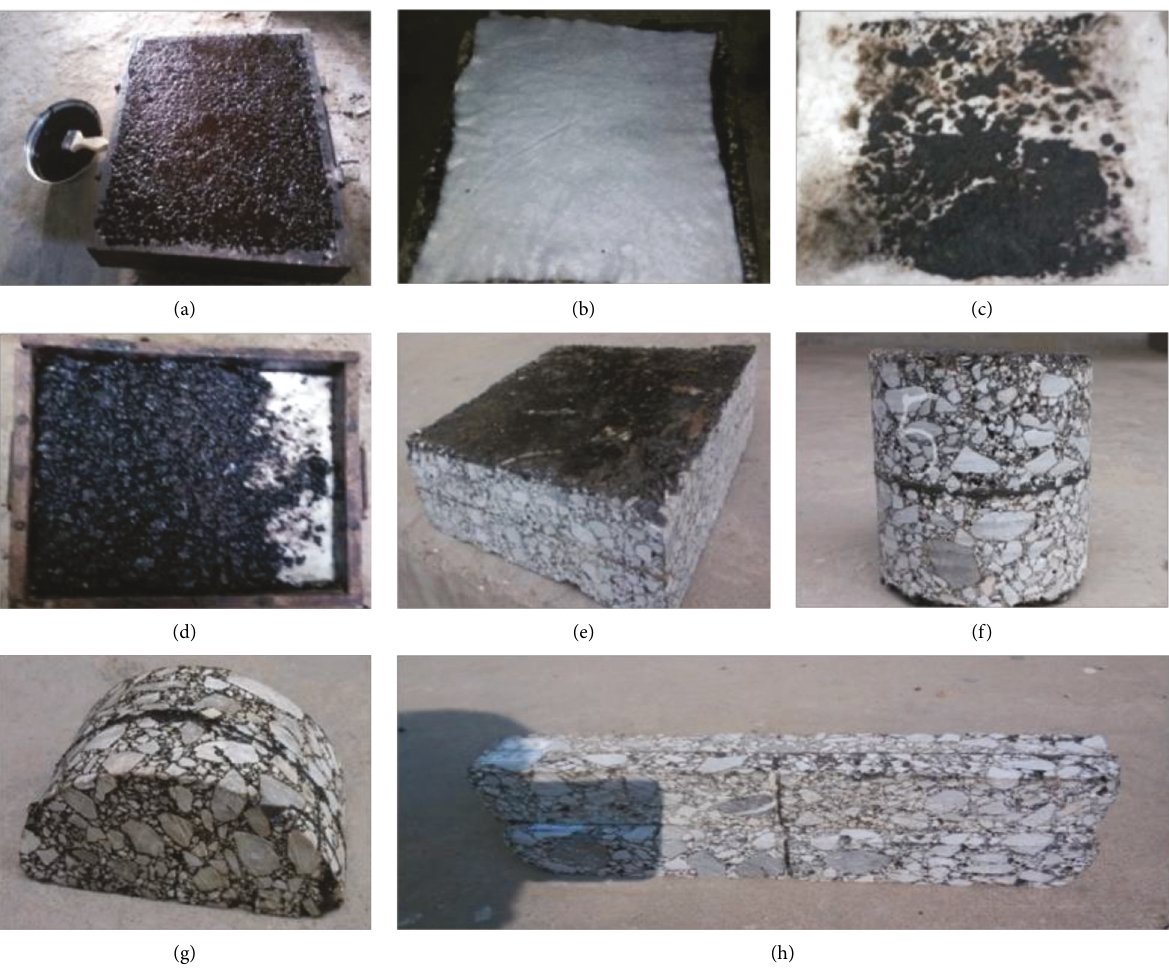
Figure 3: Specimen preparation process. (a) Applying tack coat on the bottom mixture; (b) laying geotextile; (c) geotextile after rolling; (d) filling the upper layer of asphalt mixture; (e) plate specimen with the interlayer of geotextile; (f) cylinder specimen with the interlayer of geotextile; (g) semicylindrical specimen with the interlayer of geotextile; (h) composite beam specimen with